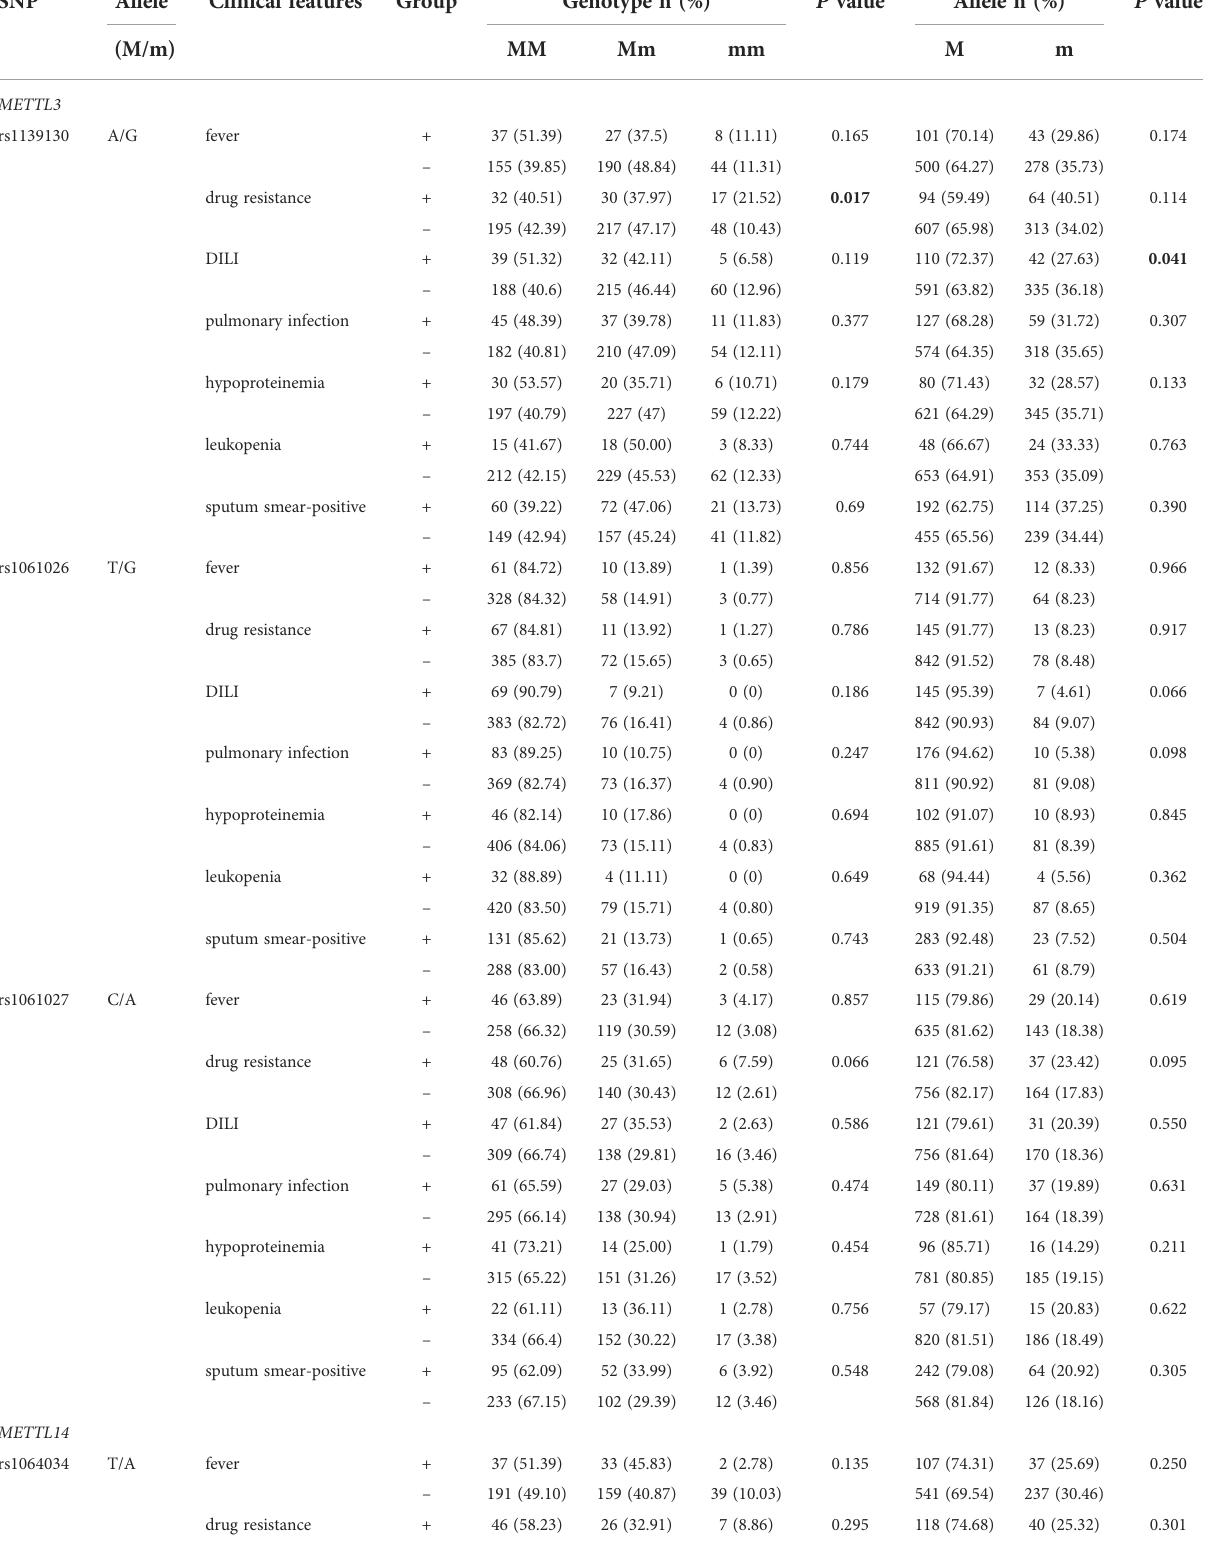
TABLE 2 Associations between METTL3 , METTL14 , and WTAP genes polymorphisms and clinical features of PTB patients. SNP